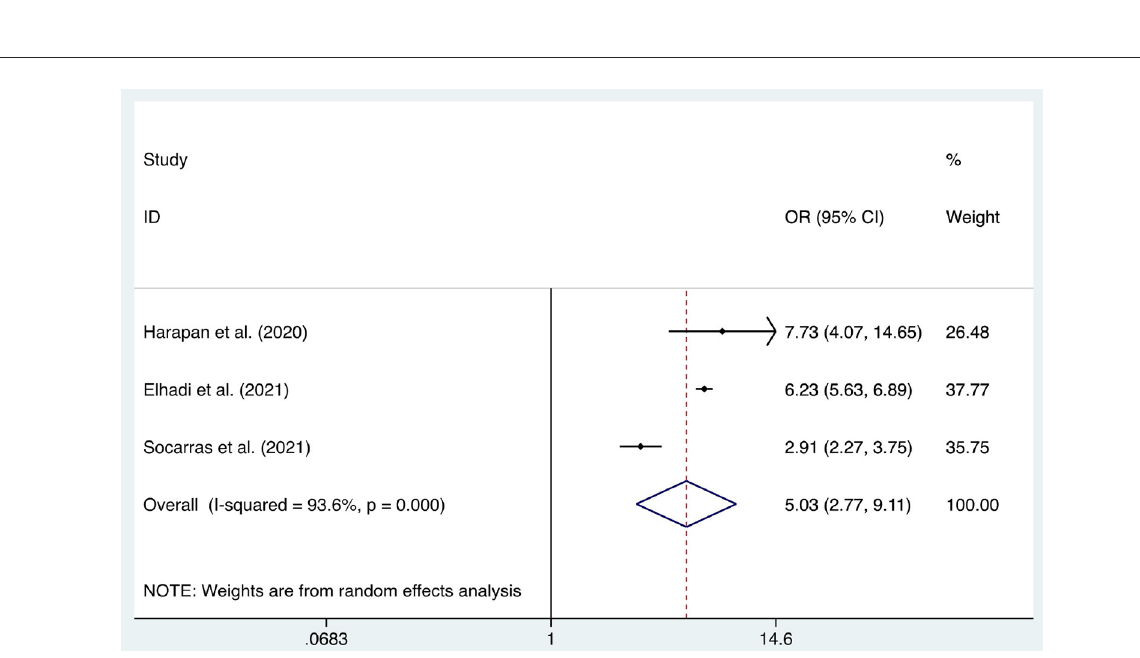
FrontiersinPublicHealth